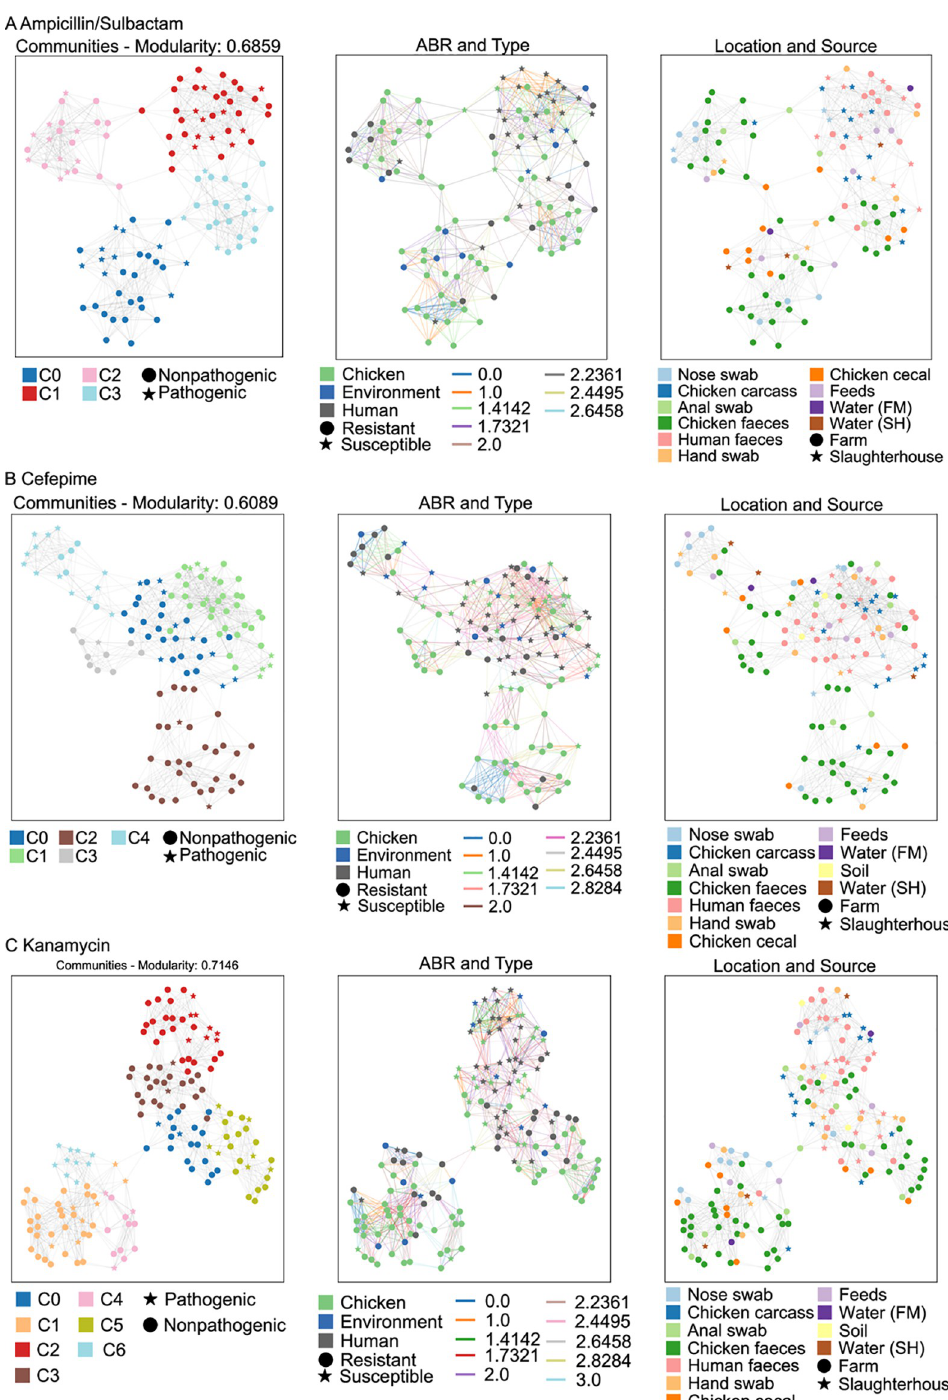
Fig 3. Networks of AMR-associated genes shared across host species (animals and workers) and environments (farm and slaughterhouse) for three antibiotics. The AMR-associated gene sharing networks for: (A) ampicillin/ sulbactam, (B) cefepime, and (C) kanamycin are shown. For each network: (i) Panel on the left, indicates the communities and their respective numbers found using Louvain heuristics. Each community is indicated with a distinct colour. Each community is a set of nodes or clusters, which are densely and connected with statistical significance and identically coloured. For each network the node represents a sample and is shown in a distinct colour and shape depending on the metadata of the sample (e.g., source, AMR profile, location). In all panels the nodes are